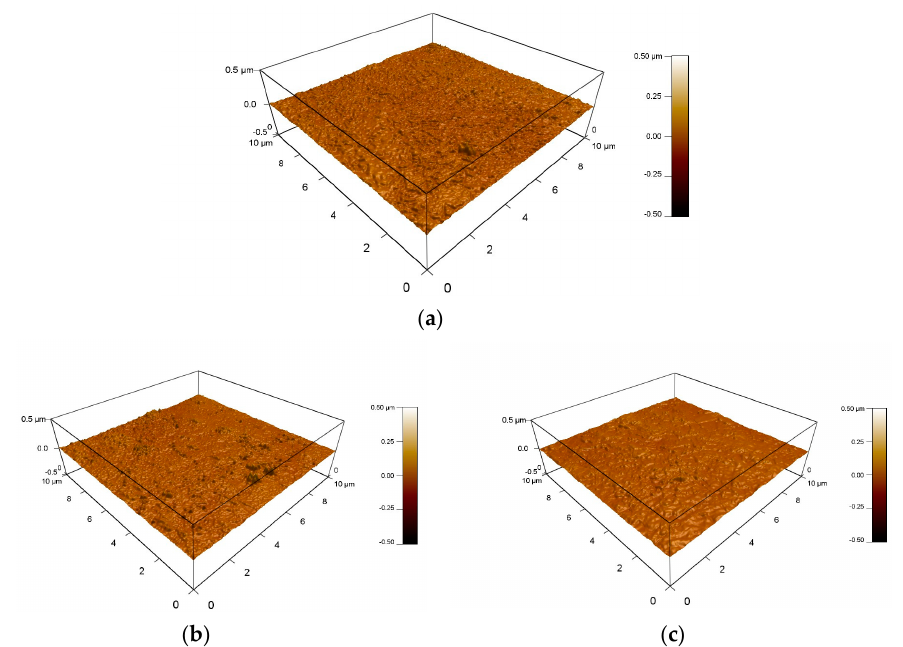
Figure 16. AFM height images of the PU films treated by plasma (180 s) in gas mixtures with a concentration of 50% of each gas: ( a ) N 2 /O 2 ( R a = 8.8 nm), ( b ) Ar/O 2 ( R a = 13.5 nm), and ( c ) N 2 /Ar ( R a = 8.4 nm).